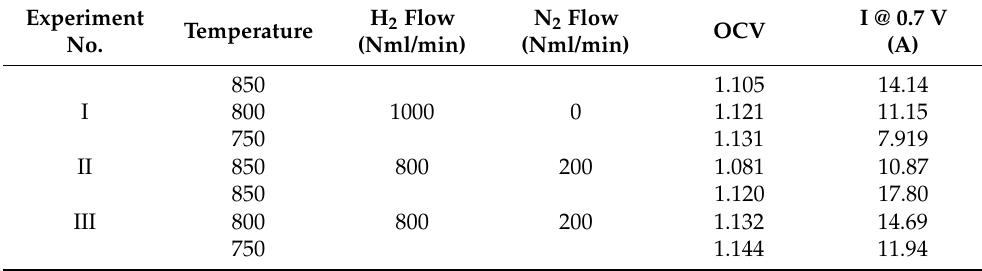
Table 3. Fuel mixture flows, temperatures and basic results for reference